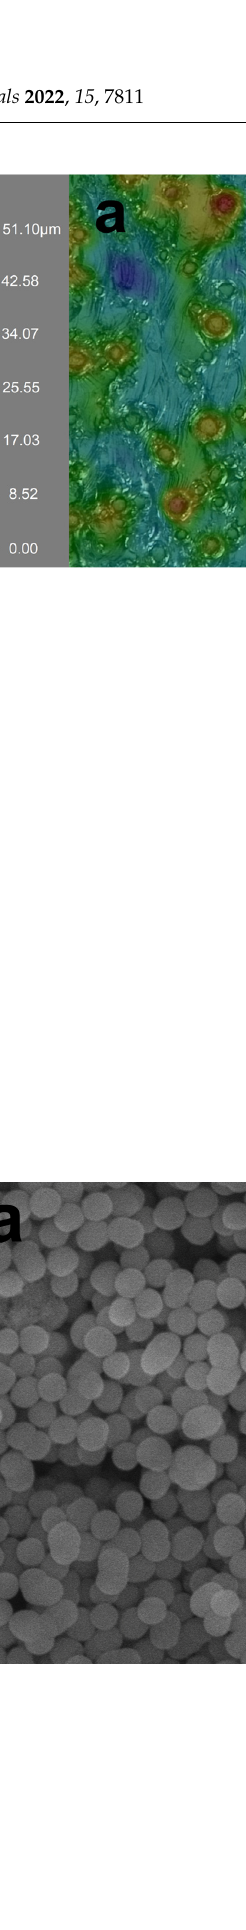
Figure 2. Morphology ( a ) and particle size distribution ( b ) of MBG nanospheres fabricated by sol–gel.